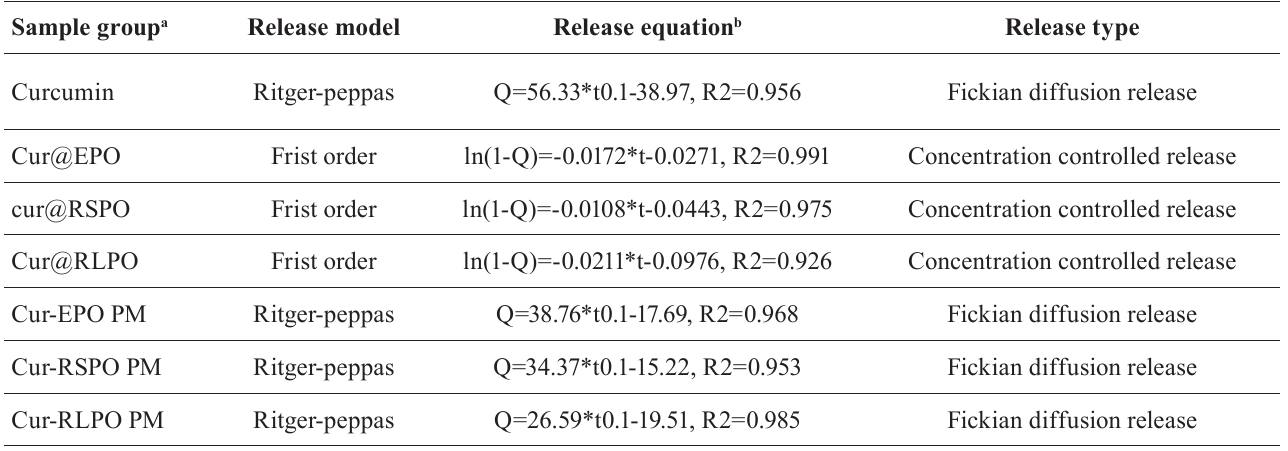
TABLE III - Release model and kinetics of curcumin, solid dispersion and physical mixture in simulated intestinal